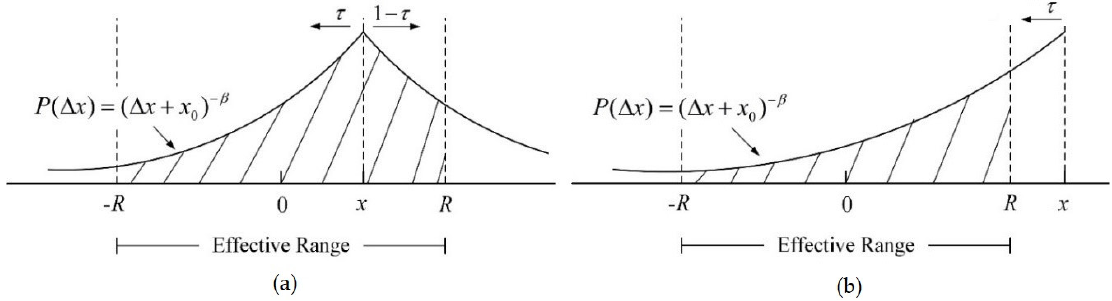
Figure 1. The market and a consumer’s movement: ( a ) A consumer’s movement when his/her location is x < R ; ( b ) A consumer’s movement when his/her location is x > R